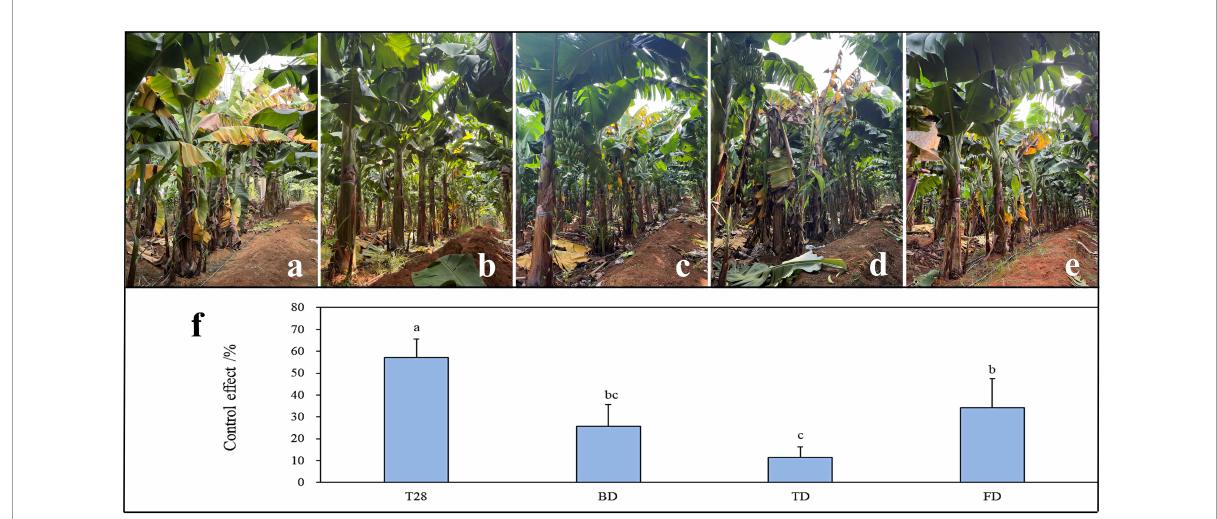
FIGURE5 Control effect of different treatments against Fusarium wilt of banana in the field. (a) Control, (b) the biocontrol strain combination of T28 (T28), (c) Bacillus subtilis (BD), (d) Trichoderma harzianum (TD), and (e) Carbendazim (FD). (f) Data presented are the control effects of the four treatments against Fusarium wilt of banana after four consecutive applications. Values are the means ( ± SEM) of the three replications. Different lowercase letters above the bars denote significant differences among treatments ( P <